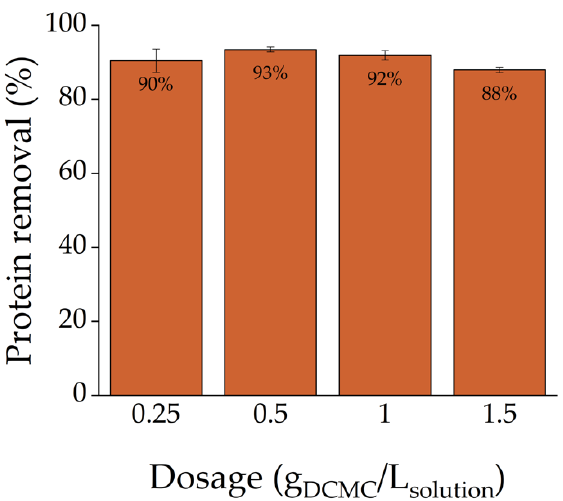
Figure 5. Effect of adsorbent dosage on the adsorption of Cyt C onto DCMC. Each value is reported as mean ± SD of triplicate independent experiments. as mean ± SD of triplicate independent